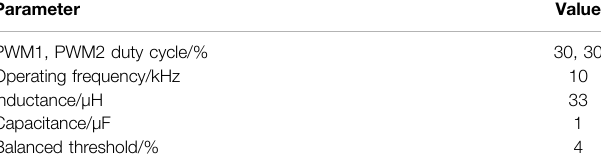
TABLE 4 | Balancing experiment parameters.